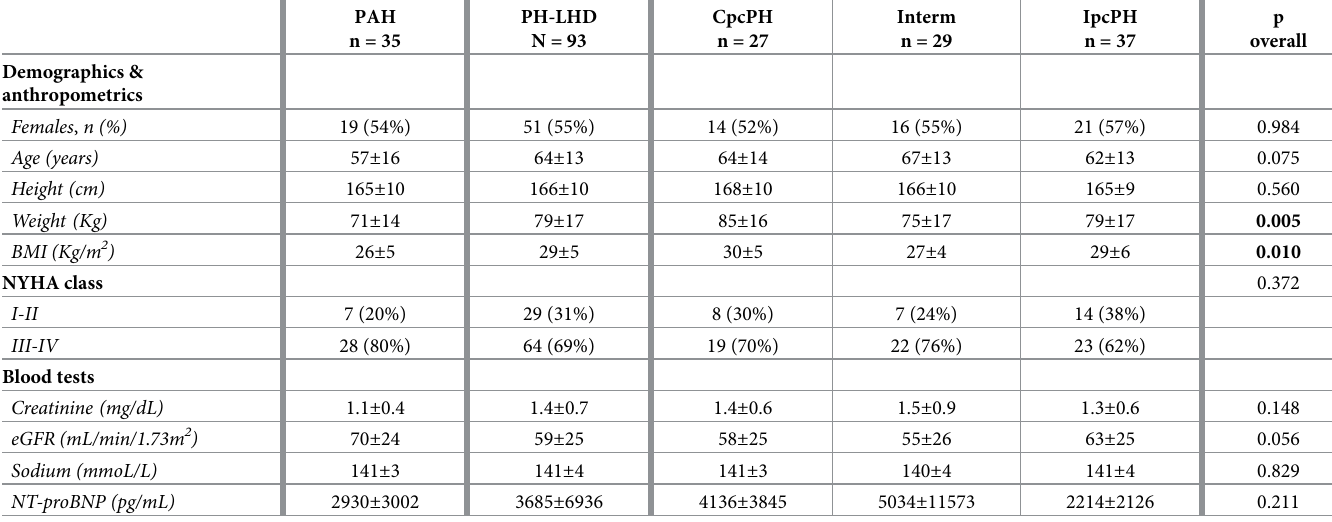
Table 2. Patients’ general